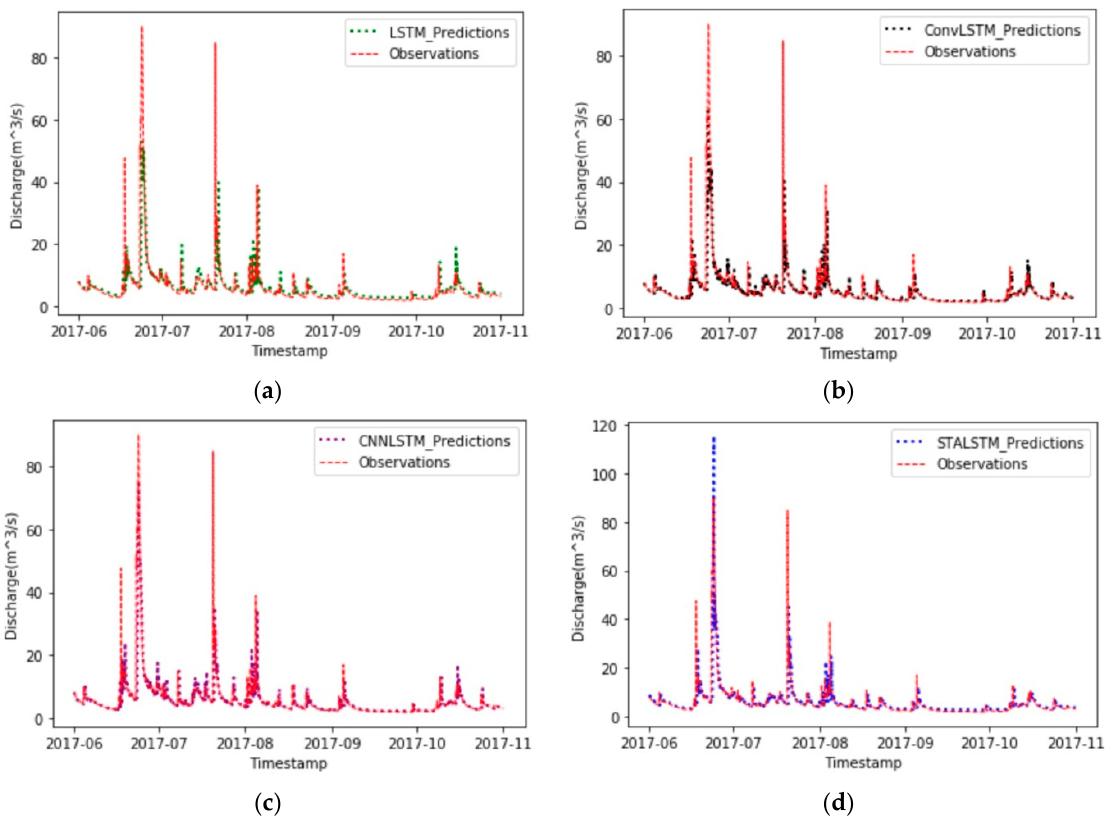
Figure 9. Comparing the predictions and the observations. ( a ) LSTM model, ( b ) ConvLSTM model, ( c ) CNN-LSTM model, ( d ) STA-LSTM